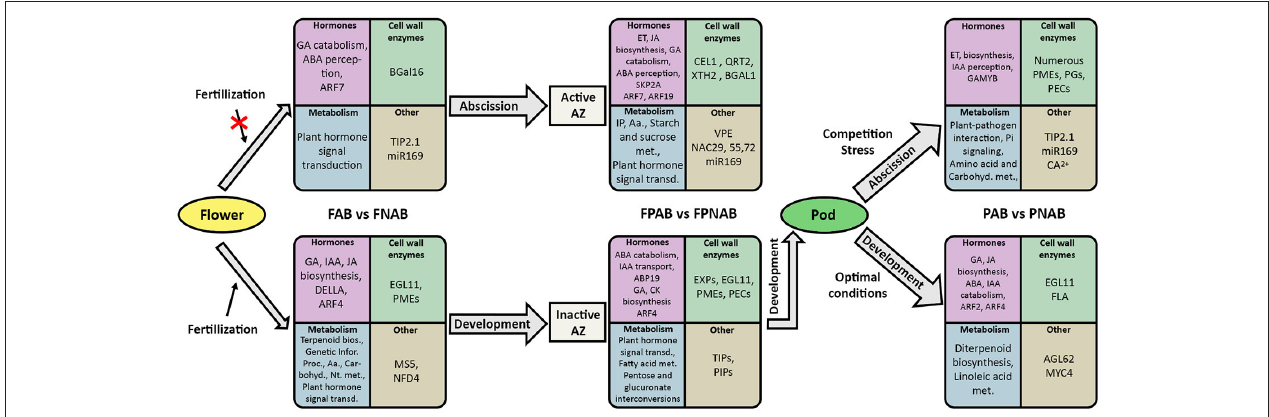
FIGURE 9 | Diagram showing the complex changes in yellow lupine abscising generative organs and organs continuing their development on the basis of the obtained